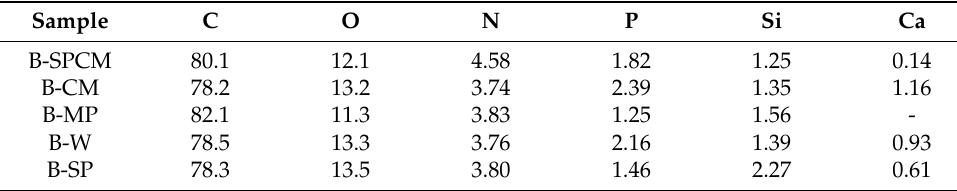
Table 2. XPS atomic percentage composition of various biochar samples.